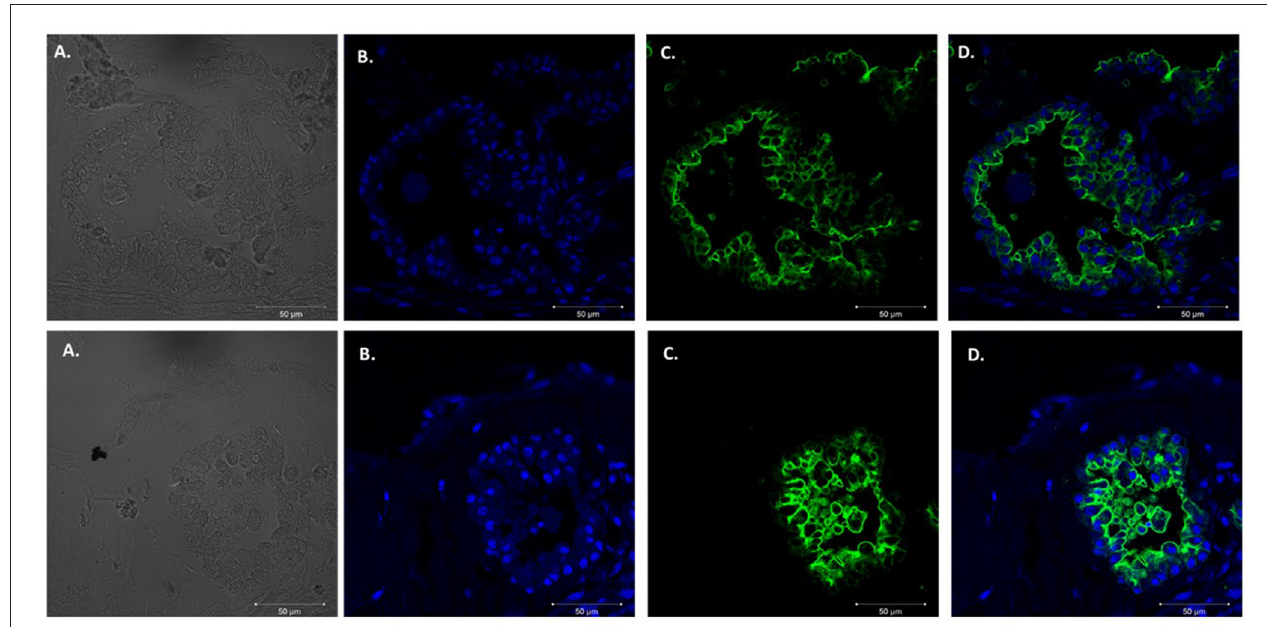
FIGURE 2 | Type 1 alveolar cell marker expression. Two independent organoids stained with Aquaporin 5 antibodies (AQP5); a membrane bound cell marker for type I alveolar epithelial cells pseudo labeled green. Left to right. (A) Bright field images organoids. (B) Nuclei stained with DAPI. (C) AQP5 (membrane bound staining pattern) of AEC1 cells. (D) Combination of nuclei and AQP5 staining. Scale bars are 50 µ m.